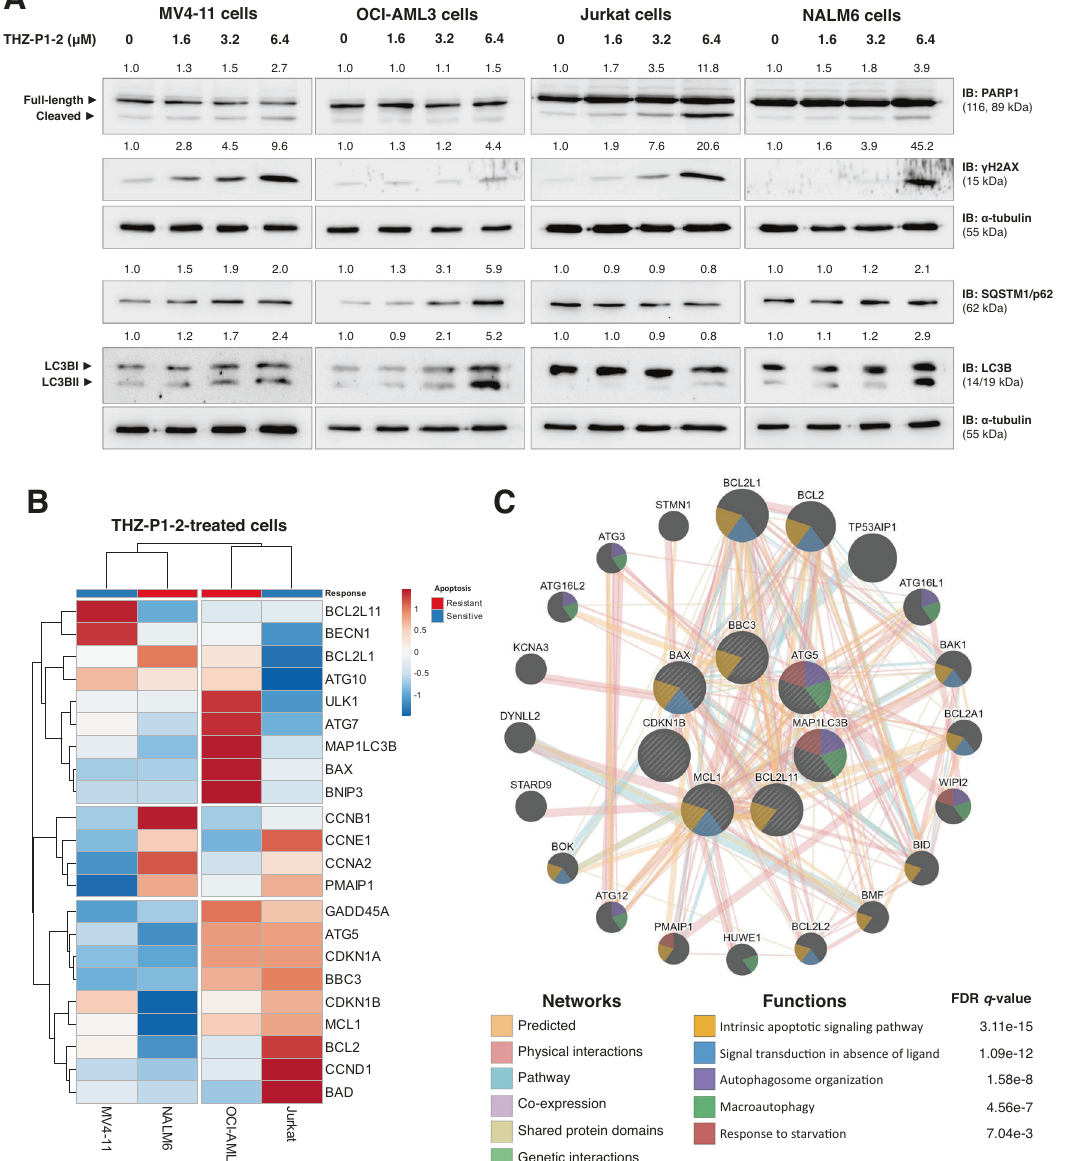
Fig. 3 THZ-P1-2 induces markers of apoptosis, DNA damage, and blockage of autophagic fl ow. A Western blot analysis for PARP1, γ H2AX, p62/SQSTM1, and LC3B in total extracts from MV4-11, OCI-AML3, Jurkat, and NALM6 cells treated with vehicle or with increasing doses of THZ- P1-2 (1.6, 3.2, and 6.4 µM) for 24 h. Membranes were reincubated with α -tubulin antibody and developed with the SuperSignal ™ West Dura Extended Duration Substrate system and GBox. Band intensities of cleaved-PARP1, γ H2AX, p62/SQSTM1, and LC3B were corrected by α - tubulin expression and normalized by vehicle-treated cells. B Heatmap depicting the gene expression pro fi le of leukemic cell lines treated with vehicle or THZ-P1-2 (6.4 μ M) for 24 h. The blue color in the heatmap indicates decreased mRNA levels, while red indicates induced mRNA levels, which were normalized by vehicle-treated cells ( n = 4). Leukemia cells that showed the lowest rates of THZ-P1-2-induced apoptosis were considered resistant. C Network for THZ-P1-2 modulated genes constructed using the GeneMANIA database (https://genemania.org/). A total of seven genes ( BBC3 , ATG5 , MAP1LC3B , MCL1 , CDKN1B , BAX , and BCL211 ) were signi fi cantly modulated in all cell lines tested and are illustrated as crosshatched circles; the interacting genes included by modeling the software are indicated by circles without crosshatched. The main biological interactions and associated functions are described in the data have indicated that leukemia cells may rely more on the accumulation of mitochondrial reactive oxygen species and mitochondrial metabolism and are more responsive to venetoclax DNA damage [31], which was con fi rmed by our data. [8, 32]. Since THZ-P1-2 led to mitochondrial damage and reduced The reduction in cellular metabolism observed upon THZ-P1-2 cellular metabolism, we investigated the effects of the combina- exposure was timely in the context of acute leukemia. Corrobor- tion of both drugs on OCI-AML3 cells, a leukemia cell line that is ating our fi ndings, it has been demonstrated that the loss of highly resistant to venetoclax. The combined treatment showed PIP4K2s leads to alterations in mitochondrial structural and synergistic effects, reducing the IC 50 of venetoclax and strongly functional integrity, as observed in double PIP4K2A/B knockout mice or inhibition by shRNA in solid tumor cell lines [25]. Recent increasing apoptosis induction (Supplementary Fig. 1). Clinical